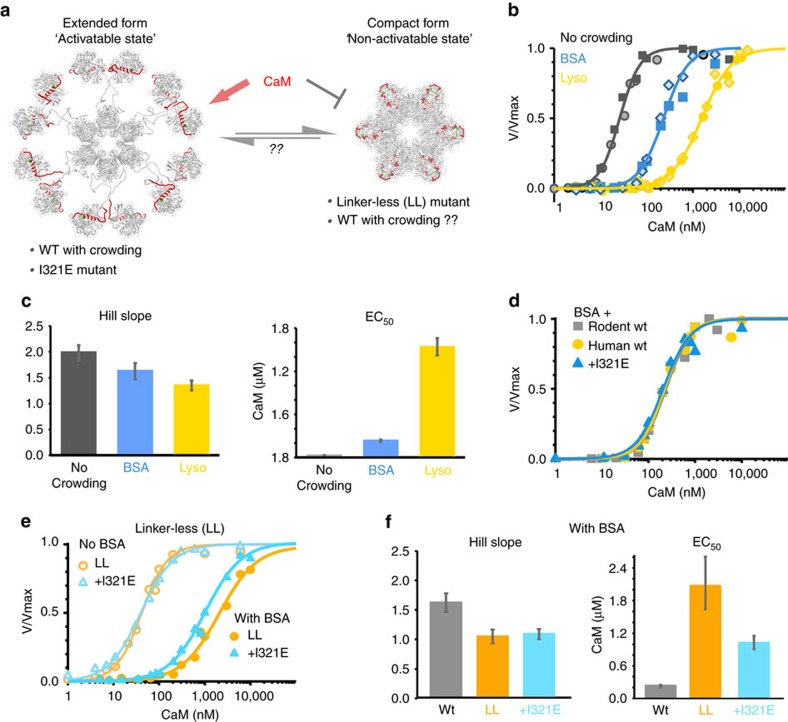
Full-length CaMKIIα wild type expressed in eukaryotic cells remains largely in an extended conformation even during molecular crowding.(a) Models of the compact versus extended CaMKII holoenzyme conformations, which differ in their accessibility to Ca2+/CaM. The compact conformation has been described for a linker-less (LL) CaMKII and suggested during molecular crowding also for wild type (WT) based on increased Hill slope; the I321E mutation prevented the compact conformation even for the LL mutant23. (b) Ca2+/CaM dose/response curves for in vitro activation of rodent CaMKII without crowding (Contr) or with crowding by 150 mg ml−1 BSA or lysozyme (lys). The curve fits shown are based on data from two independent experiments; the curve fits from the individual experiments are shown Supplementary Fig. 6. (c) The Hill slope was not increased by molecular crowding and thus gave no indication for induction of a compact conformation. By contrast, the EC50 was increased dramatically by lysozyme and to a lesser extent by BSA. (d) Human CaMKIIα and its I321E mutant that is incompetent for the compact conformation showed the same Ca2+/CaM responses during crowding with BSA as rodent CaMKIIα. (e,f) Linker-less (LL) CaMKII and its I321E mutant showed the same Ca2+/CaM response without crowding. However, crowding with BSA caused a lesser increase in E50 for the I321E mutant that is incompetent for the compact conformation. The Hill slope was identical for both linker-less mutants and no longer showed significant cooperativity under crowding conditions. Error bars represent the s.e. calculated from the curve fits.